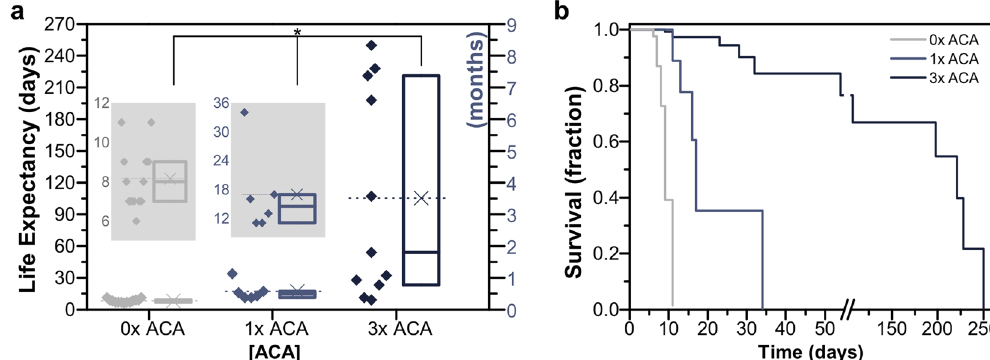
Figure 3. Bio-Bot Life Expectancy. ( a ) In the absence of any anti-fibrinolytic treatment (0x ACA), muscle strips demonstrated an average life expectancy of 8.2 ± 0.5 days until rupture. However, incubation in medium with the serine protease inhibitor ACA lengthened the life expectancy of the muscle strips. Box plots represent 25 th , 50 th and 75 th percentiles, with average values marked as (x) and whiskers representing ± SEM. Data are presented to the left of the boxes ( n = 6–13 muscle strips per condition, excluding outliers). * indicates significance ( p < 0.05) between time points. ( b ) Kaplan-Meier survival analysis provided an additional method of comparison by plotting survival fraction of each treatment group as a function of time.